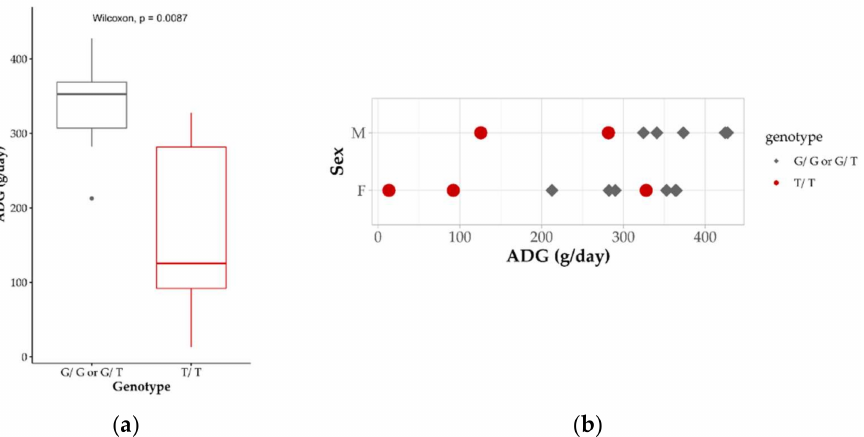
Figure 3. CCDC65 genotype effect on average daily gain during the 0–15 day period. Mean ADG (g/day) according to CCDC65 c.521G > T genotype ( a ) and ADG distribution by sex (M: male; F: female) and genotype ( b